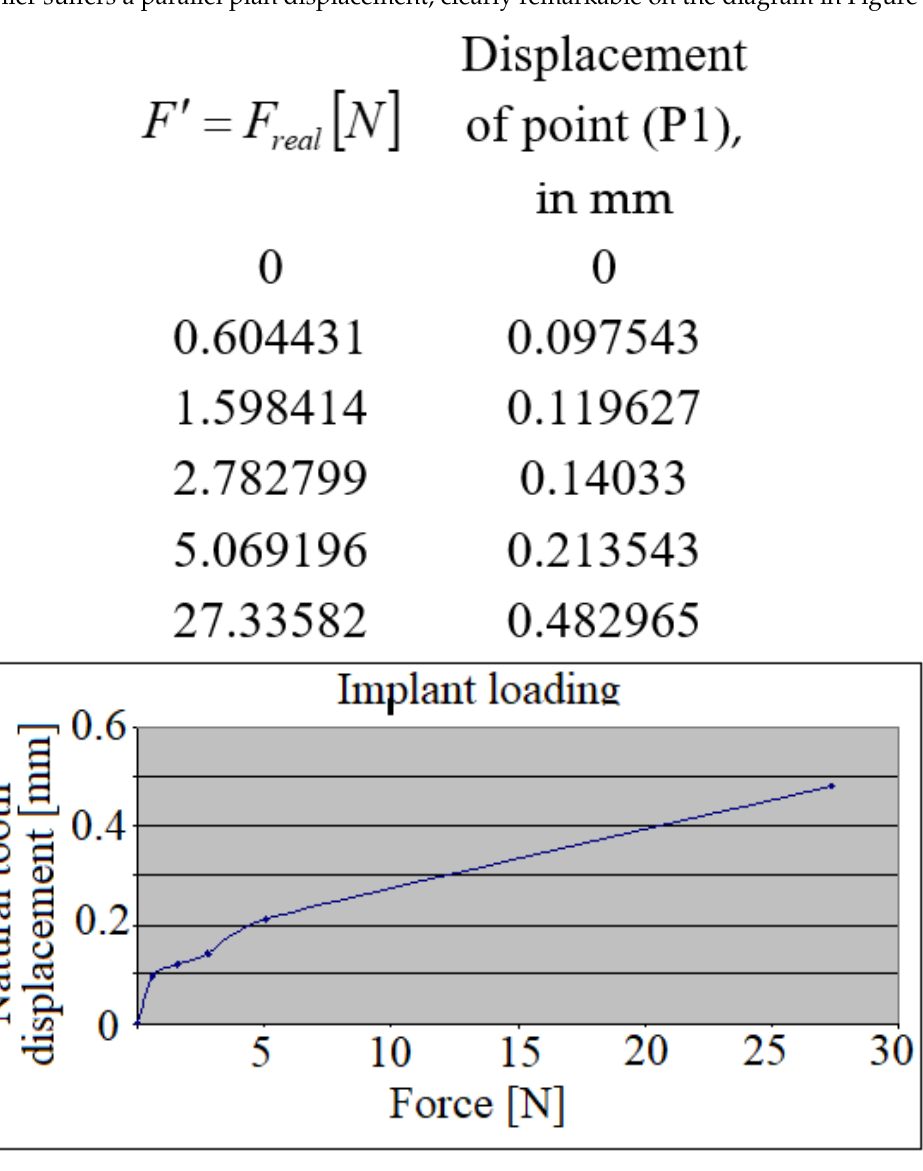
Figure 6. The natural tooth’s displacement during the implant’s loading.